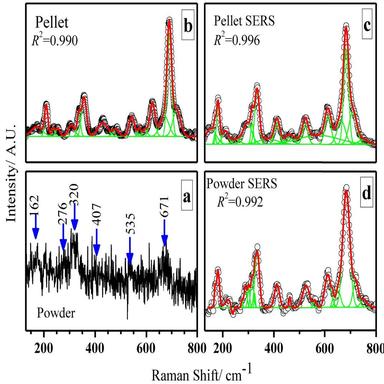
Normal Raman spectra of (a) Powder (b) Pellet and SERS spectra of (c) Pellet and (d) Powder. The continuous lines through the symbols are fit to the experimental data.